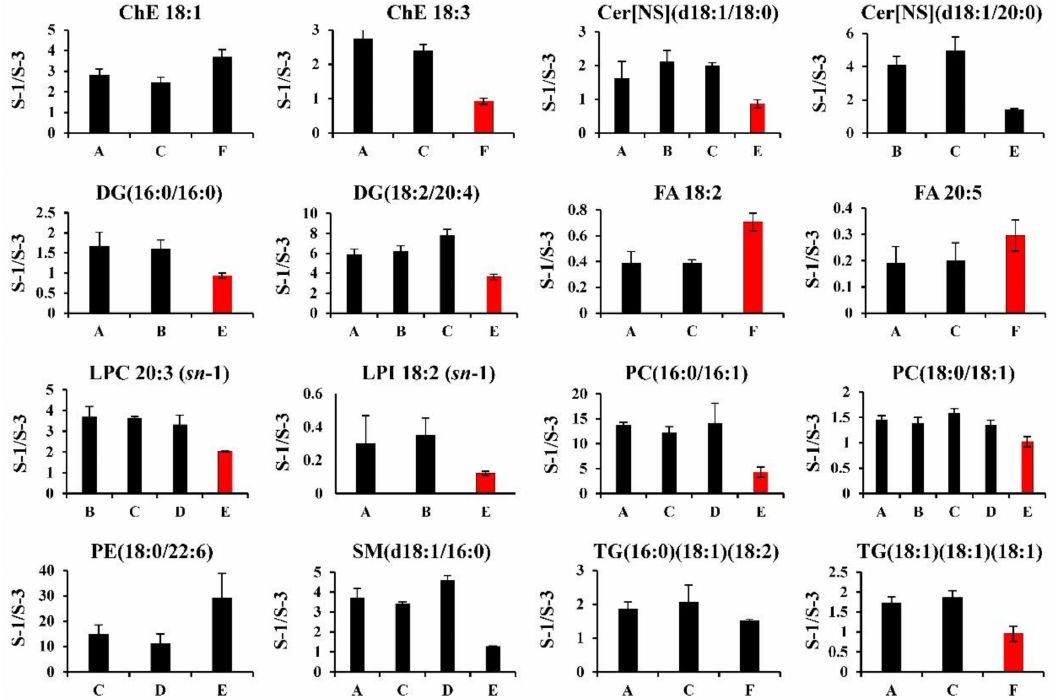
Figure 5. Examples of hydrophobic metabolites with remarkable differences between LC/MS and SFC/MS. As examples of hydrophobic metabolites with the remarkable differences between LC/MS and SFC/MS, the results of the relative quantification (S-1/S-3) from the first step data treatment